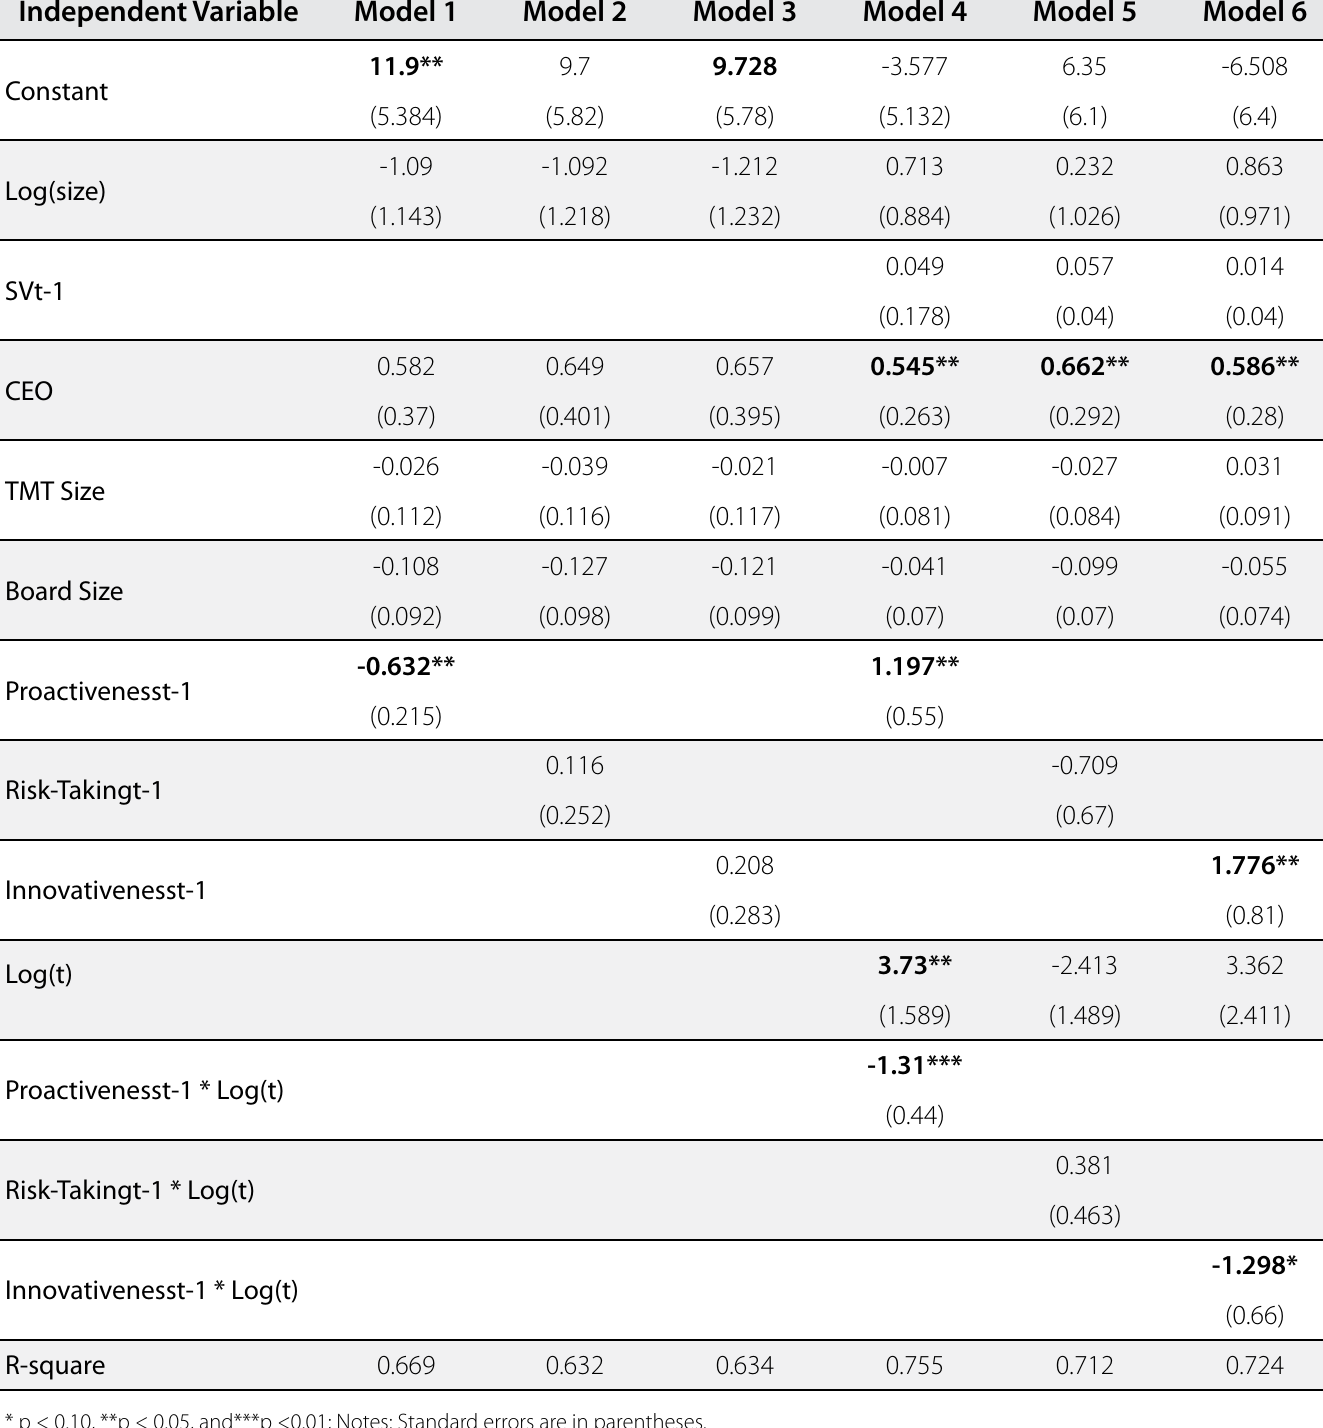
Table 3. Effect on Value Creation; Dependent Variable = Value Creation